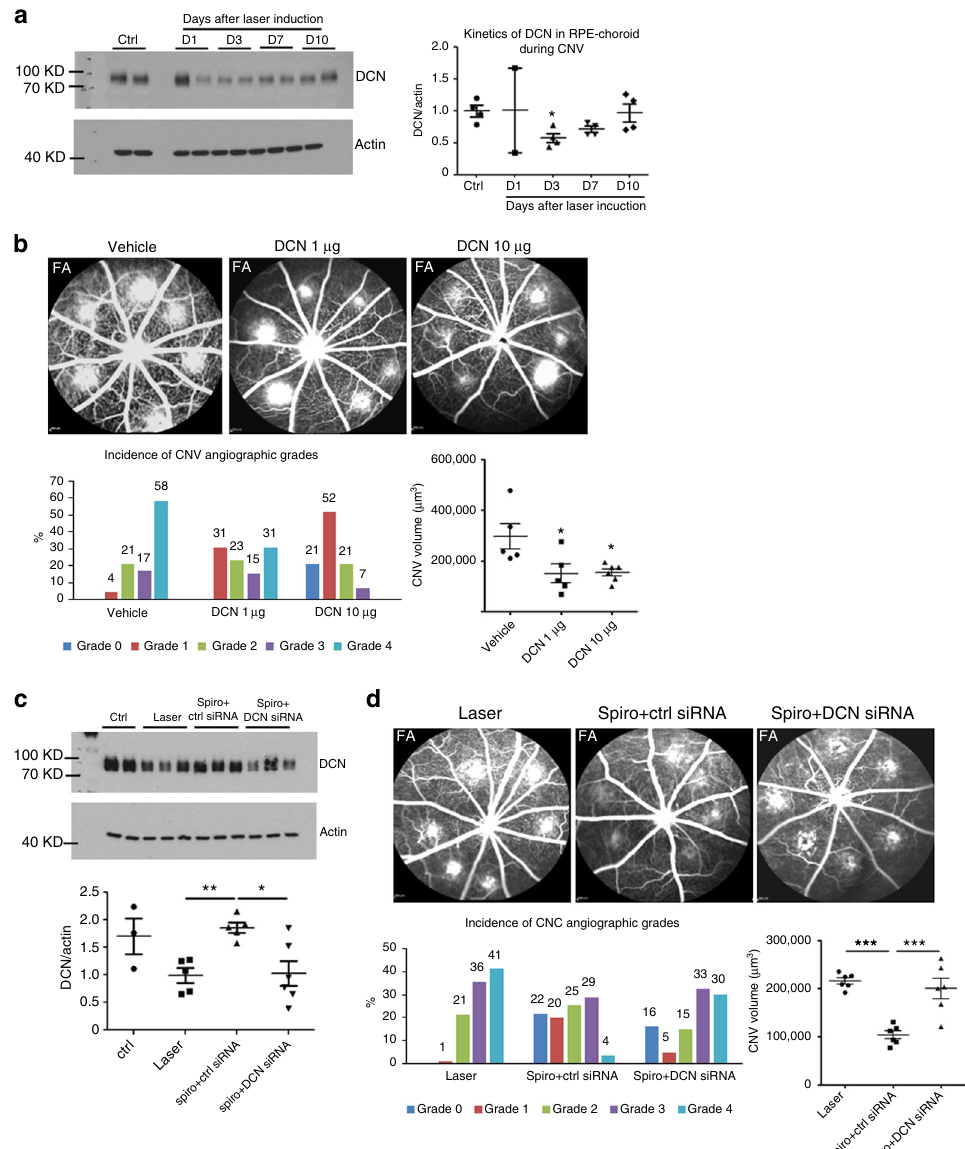
Fig. 4 Spironolactone inhibits CNV through induction of anti-angiogenic decorin protein. a On western blot, the decorin (DCN) level decreases in the rat retinal pigment epithelium (RPE)-choroid at different time point (day 1, 3, 7, and 10) after laser induction compared to the normal rat RPE-choroid (ctrl). Densitometric quanti fi cation shows signi fi cant decrease of DCN protein in rat RPE-choroid at day 3 after laser induction. b Intravitreal injection (IVT) of recombinant mDCN protein in rat eyes inhibits choroidal vascular leakage on fl uorescein angiography (FA); DCN 10 µ g/ml signi fi cantly reduces the CNV angiographic grades ( p = 0.02), whereas DCN at both 1 µ g/ml ( p = 0.0461) and 10 µ g/ml ( p = 0.0388) decrease the size of CNV induced by laser. c IVT of DCN siRNA in rat eyes with laser-induced CNV. Treatment with spironolactone (Spiro) in the presence of control siRNA signi fi cantly increases the DCN protein level in the rat RPE-choroid 48 h after laser induction. IVT of DCN siRNA prevents the increase in the DCN protein induced by spironolactone. d Treatment with spironolactone in the presence of control siRNA inhibits choroidal neovascular leakage on FA at day 14 after laser induction ( p = 0.0194). IVT of DCN siRNA at day 0 and 3 after laser induction abrogates the effect of spironolactone on vascular leakage ( p = 0.0344). Spironolactone in the presence of control siRNA reduces signi fi cantly CNV volume as compared to laser control ( p < 0.0001). DCN siRNA injected at day 0 and 3 after laser induction abrogates the effect of spironolactone on CNV volume ( p = 0.0003). Western blot data are expressed as mean ± SEM. Dots represent individual RPE-choroid sample. Non-parametric Kruskal – Wallis test was used. FA Data are expressed as the incidence of CNV angiographic grades of the total laser impacts in each group. CNV volumes are expressed as mean ± SEM of the average CNV size per rat. n represents the number of rats. Linear mixed model was used for statistical analyses. * p < 0.05, ** p < 0.01, *** p < RPE-choroid as early as 3 days after CNV induction (Fig. 4a) model. To analyze the anti-angiogenic effect of DCN in CNV, we consistent with the timing of MR upregulation in the RPE- used a recombinant mouse DCN protein that shares 87% amino- choroid (Supplementary Fig. 7a). The DCN levels partly recov- acid sequence identity with rat DCN. Intravitreous injection of ered from day 7 to day 10 (Fig. 4a), suggesting that decreased recombinant mDCN was performed after laser induction at an DCN might contribute to the pro-angiogenic balance in this CNV estimated fi nal concentration of 1 µg/ml or 10 µg/ml in rat